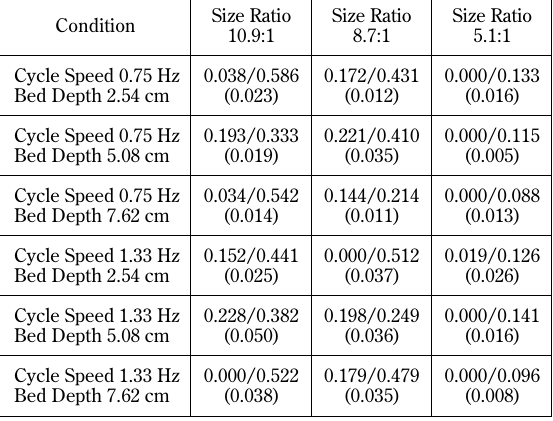
Table 5 Convective-diffusive segregation constitutive model para- meter values ( µ / δ ) at 10% strain with standard deviations between data and model in parentheses *